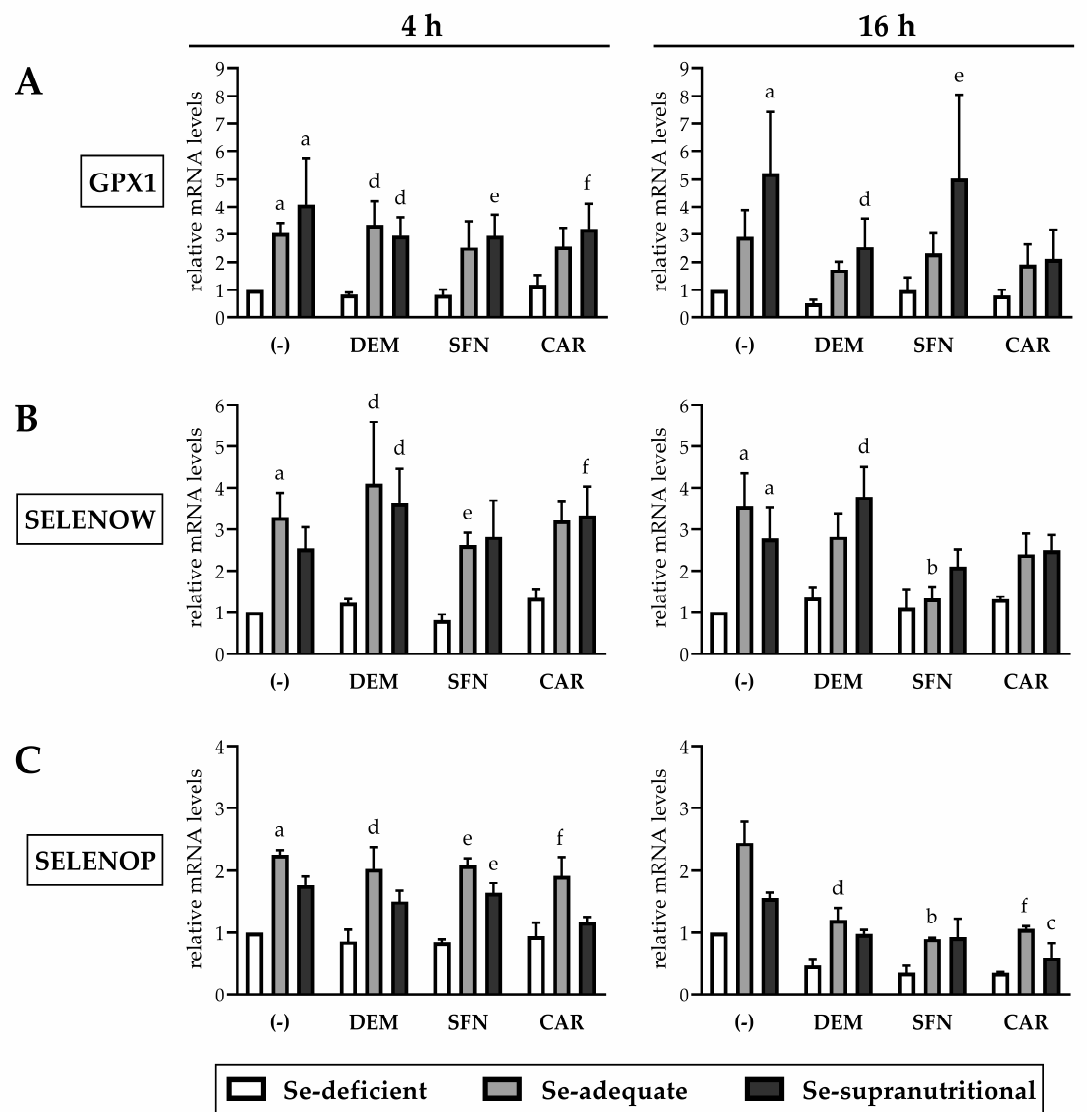
Figure 5. Impact of selenite and electrophiles on the mRNA levels of selected selenoproteins in HepG2 cells. Treatment of the cells and qRT-PCR analysis occurred as described for Figure 4 (Relative mRNA levels of GPX1 ( A ), SELENOW ( B ), SELENOP ( C )). Statistical significance ( p < 0.05): (a) significantly different from Se-deficient solvent control, (b) significantly different from Se-adequate solvent control, (c) significantly different from Se-supranutritional solvent control, (d) significantly different from Se-deficient DEM-treated cells, (e) significantly different from Se-deficient SFN-treated cells, (f) significantly different from Se-deficient CAR-treated